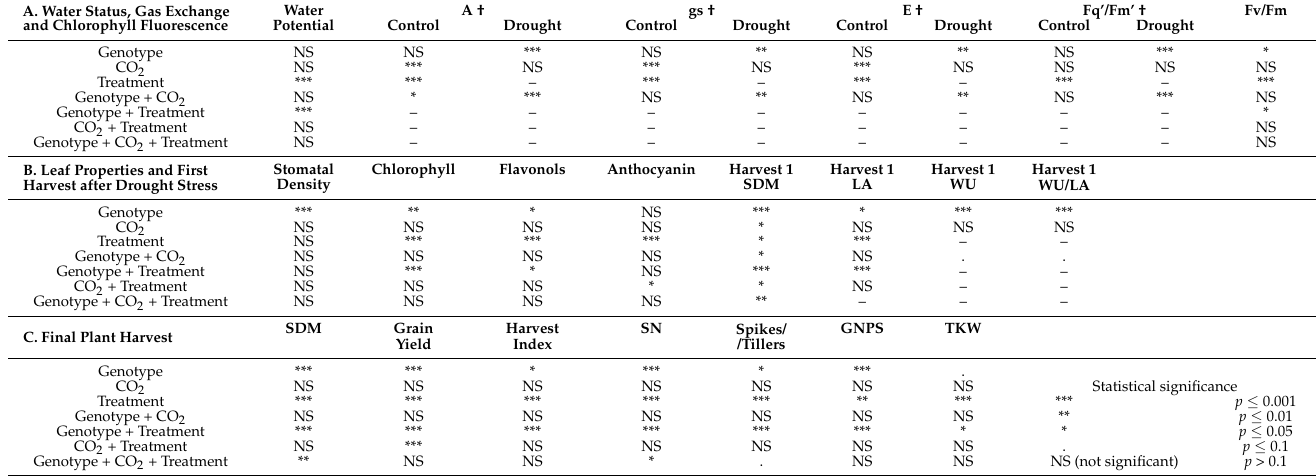
Table 1. Outputs of three-way ANOVA based on single factor effect and interaction effects divided into categories of A: Water status, gas exchange and chlorophyll fluorescence (Water potential, Net photosynthesis ( A ), stomatal conductance (gs), transpiration (E), PSII operating efficiency (Fq’/Fm’), Maximum quantum efficiency of PSII (Fv/Fm). Furthermore is the group of leaf properties and canopy characteristics at first harvest after drought stress ( B ): Stomatal density (SD), chlorophyll index (Chlorophyll), flavonol index (Flavonols), anthocyanin index (Anthocyanin), shoot dry matter (Harvest 1 SDM), leaf area (Harvest 1 LA), mean daily water use of control plants during the stress period (Harvest 1 WU), Mean daily water use per leaf area of control plants during the stress period (Harvest 1 WU/LA). The last table denotes ( C ) plant characteristics at final plant harvest: shoot dry matter (SDM), Grain yield, harvest index, number of spikes (SN), number of spikes per tiller (Spikes/Tillers), grain number per spike (GNPS), thousand kernel weight (TKW). The tests ANOVA were tested on the following variables: The three spring wheat genotypes Gladius, LM19 and LM62 (Genotype) as affected by drying conditions (Treatment) and CO 2 conditions (CO 2 ), along with interaction effects between the variables.